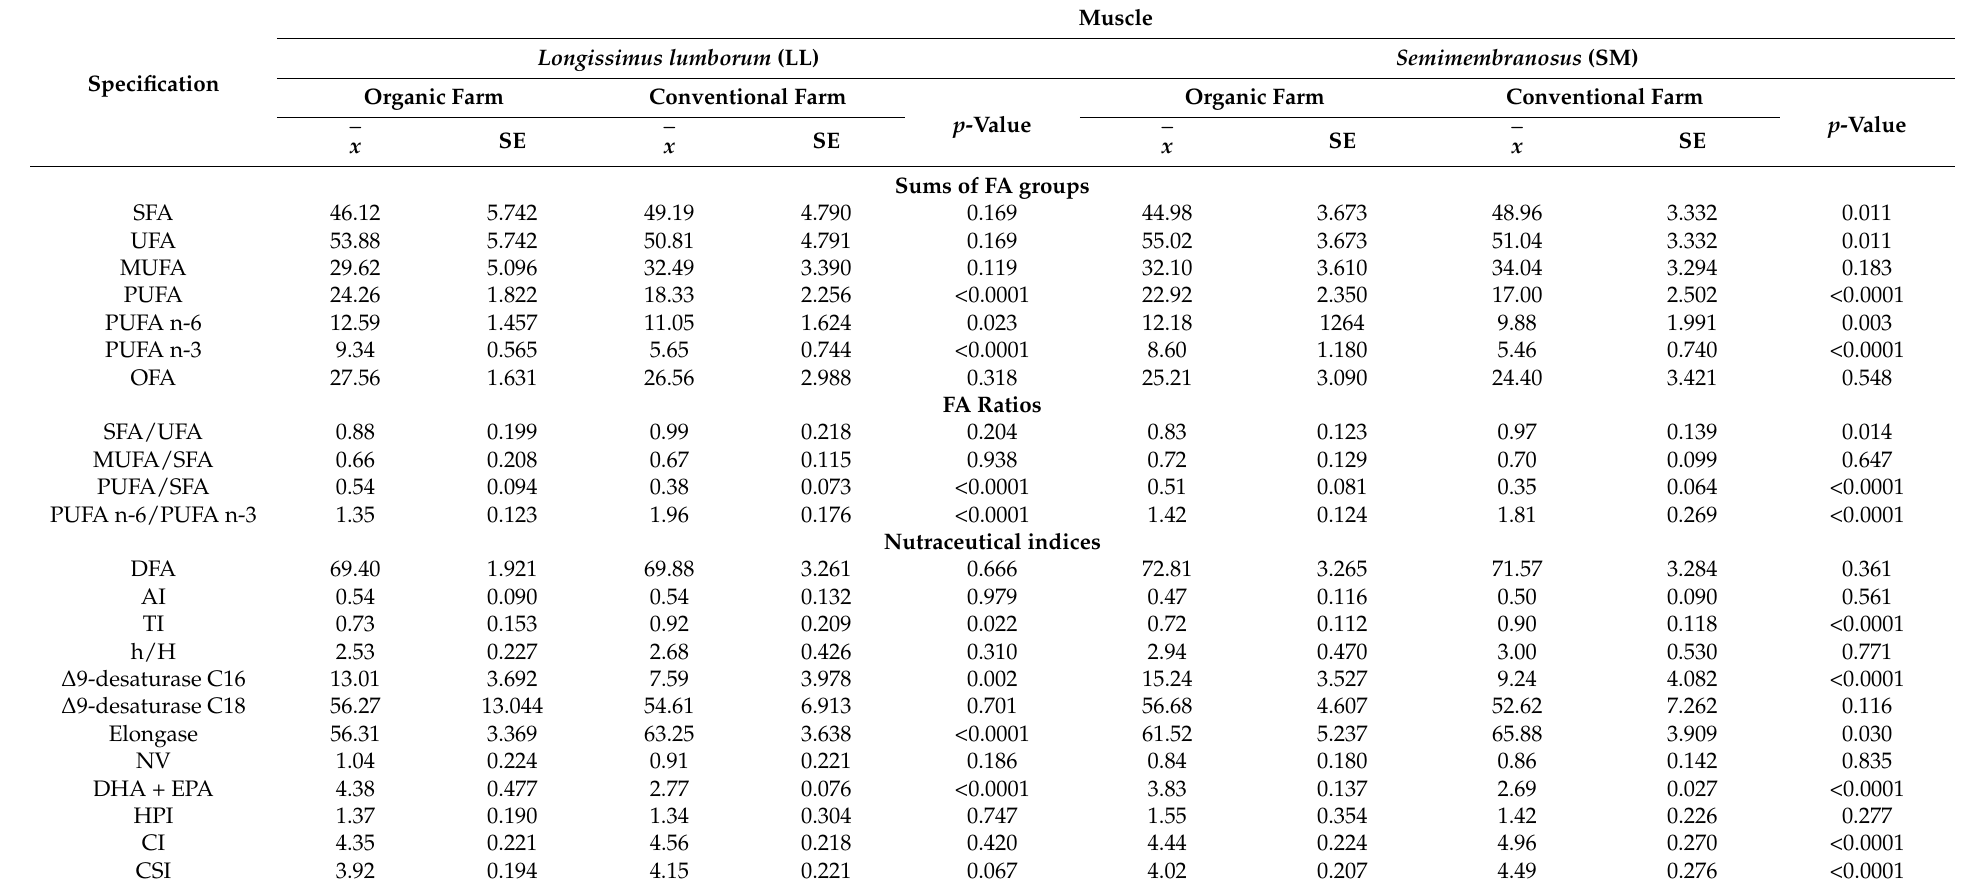
Table 2. Sums of FA groups (g · 100 g − 1 FA), fatty acid ratios, and nutraceutical indices of lipids in the meat of fallow deer from organic and conventional